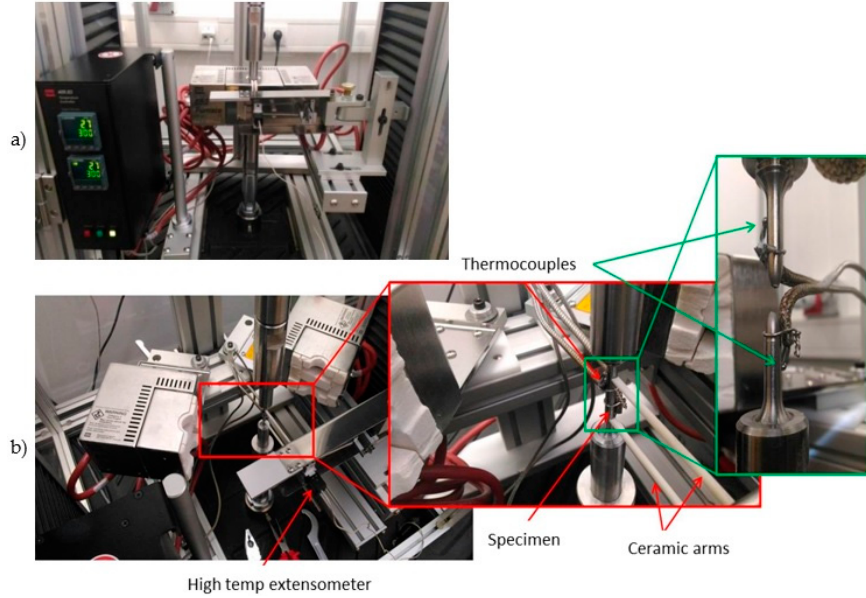
Figure 6. Experimental setup. ( a ) MTS testing equipment for high-temperature tests. ( b ) Details of specimens, fixtures, thermocouples and